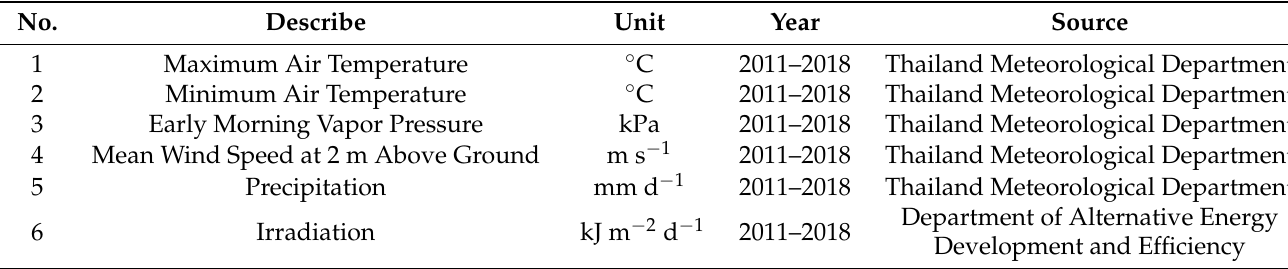
Table 1. Meteorological parameters of the WOFOST